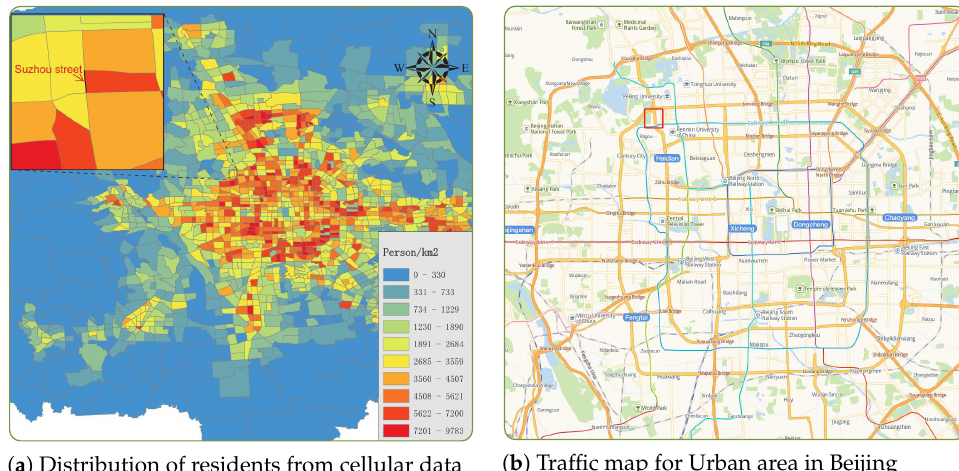
Figure 5. Location and residential population distribution of the TAZ in Beijing.